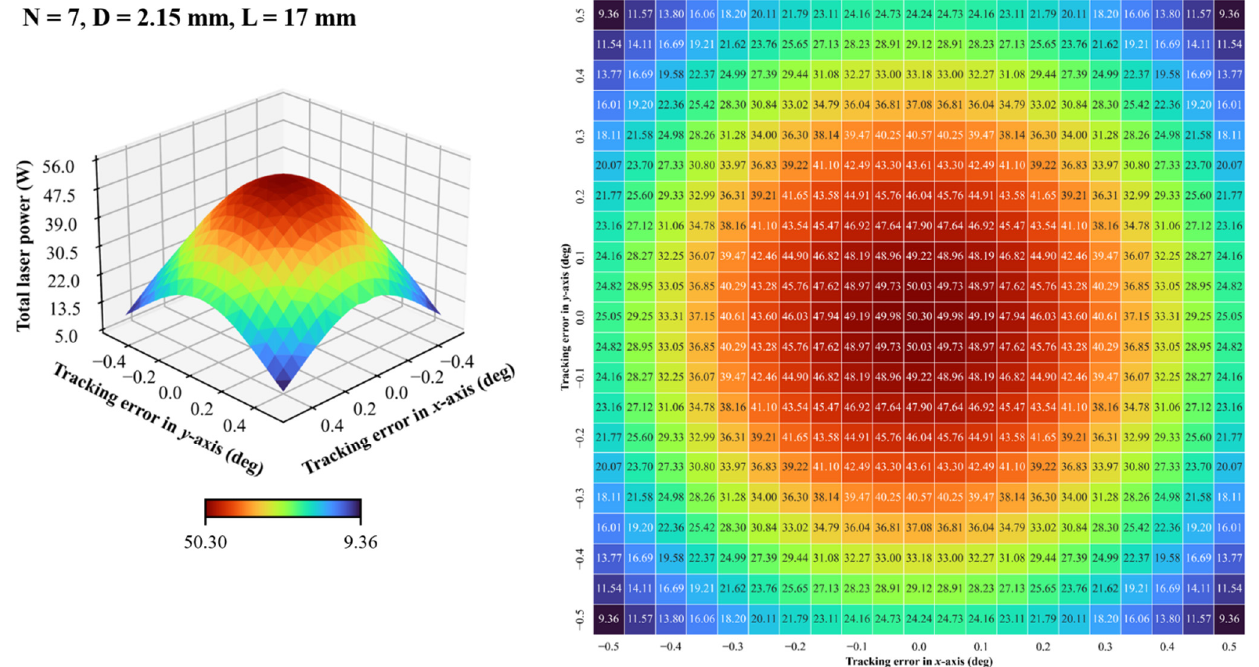
Figure 9. Total solar laser power in multimode regime as a function of the solar tracking error for the seven 2.15 mm diameter, 17 mm length rods scheme.